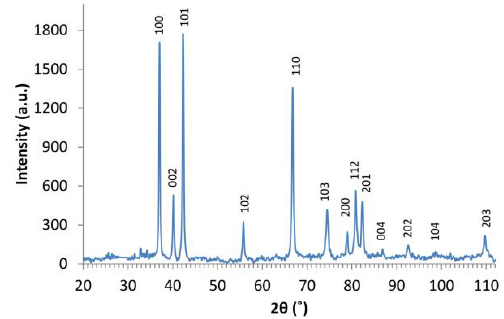
Figure 3. X-ray powder diffraction (XRD) patterns of ZnO nanostructures (λ = 0.179 nm).